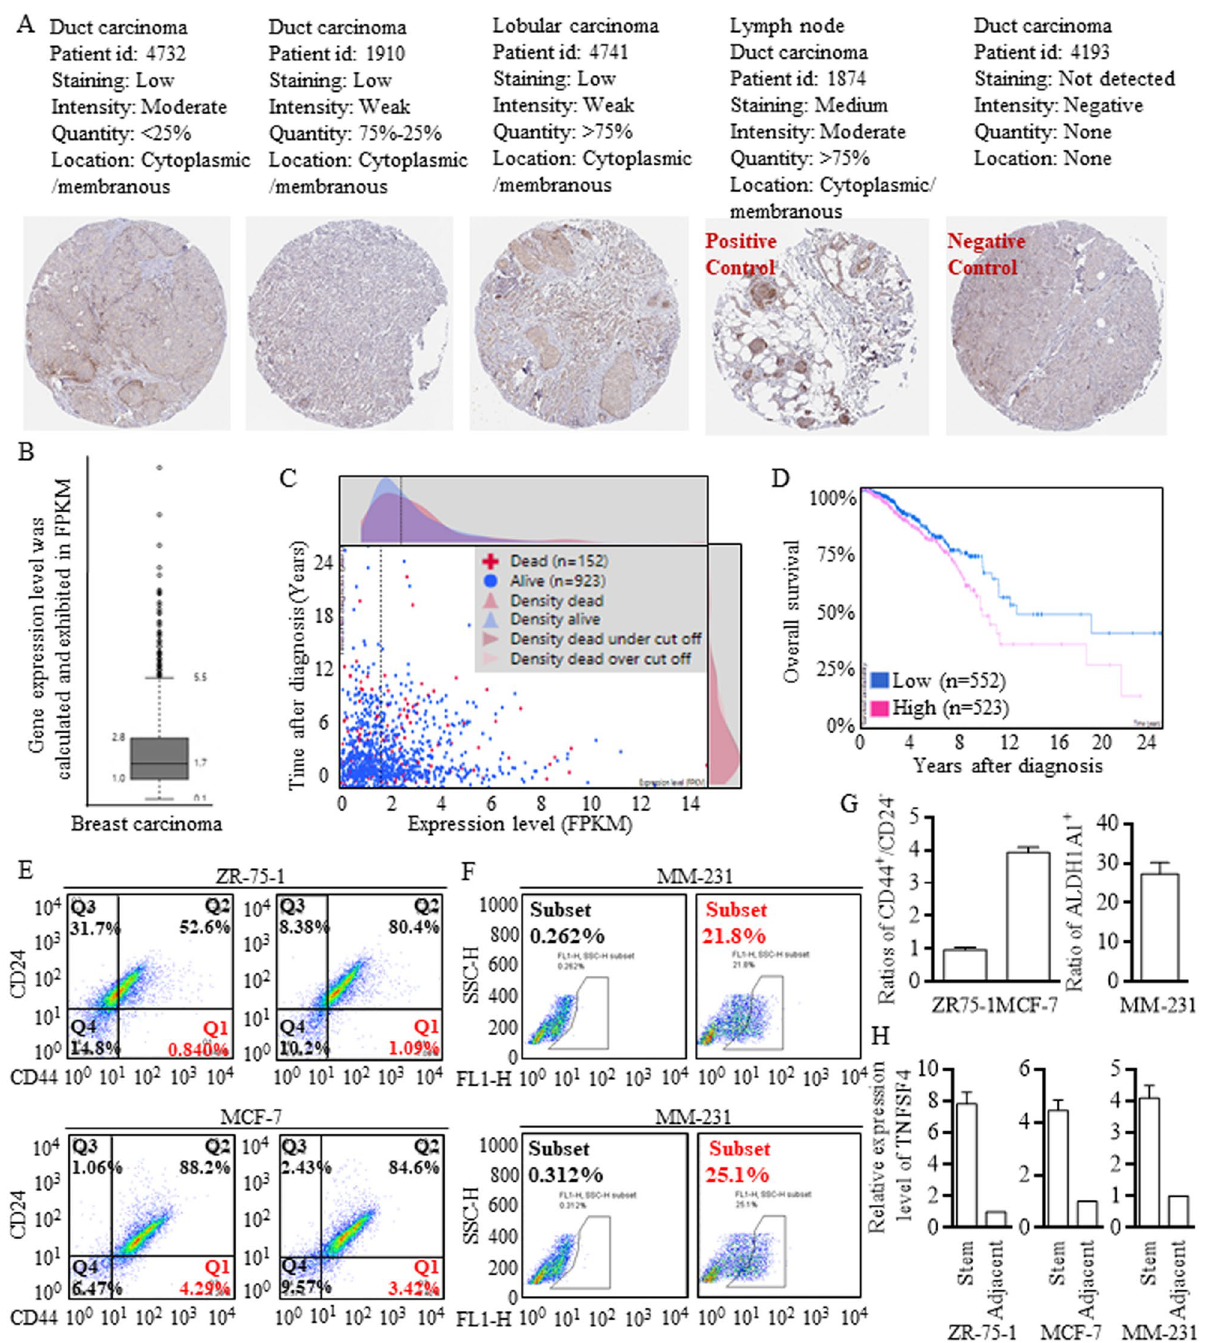
Figure 6. Exploration of the putative clinical roles of TNFSF4. ( A ) IHC staining images are shown to clarify different expression patterns (left to right, in sequence, < 25%, 25–75%, and > 75%). A lymph node slide was set as a positive control, and an unstained slide was set as a negative control. ( B ) High RNA expression of TNFSF4 was universally identified in breast carcinoma, with testing and calculation based on FPKM, and the cutoff line is labeled, which was used for clinical predictions. ( C , D ) Higher TNFSF4 expression pointed to poorer survival outcomes. ( E , F ) Flow cytometry with FACSAria sorting was applied to isolate stem cells from ZR75-1, MCF-7, and MM-231 cells. ( G , H ) Stem cells with a CD44 + /24 − or ALDH1A1 + phenotype were identified and isolated, and the TNFSF4 expression patterns in different cell lines were checked to illustrate the increased